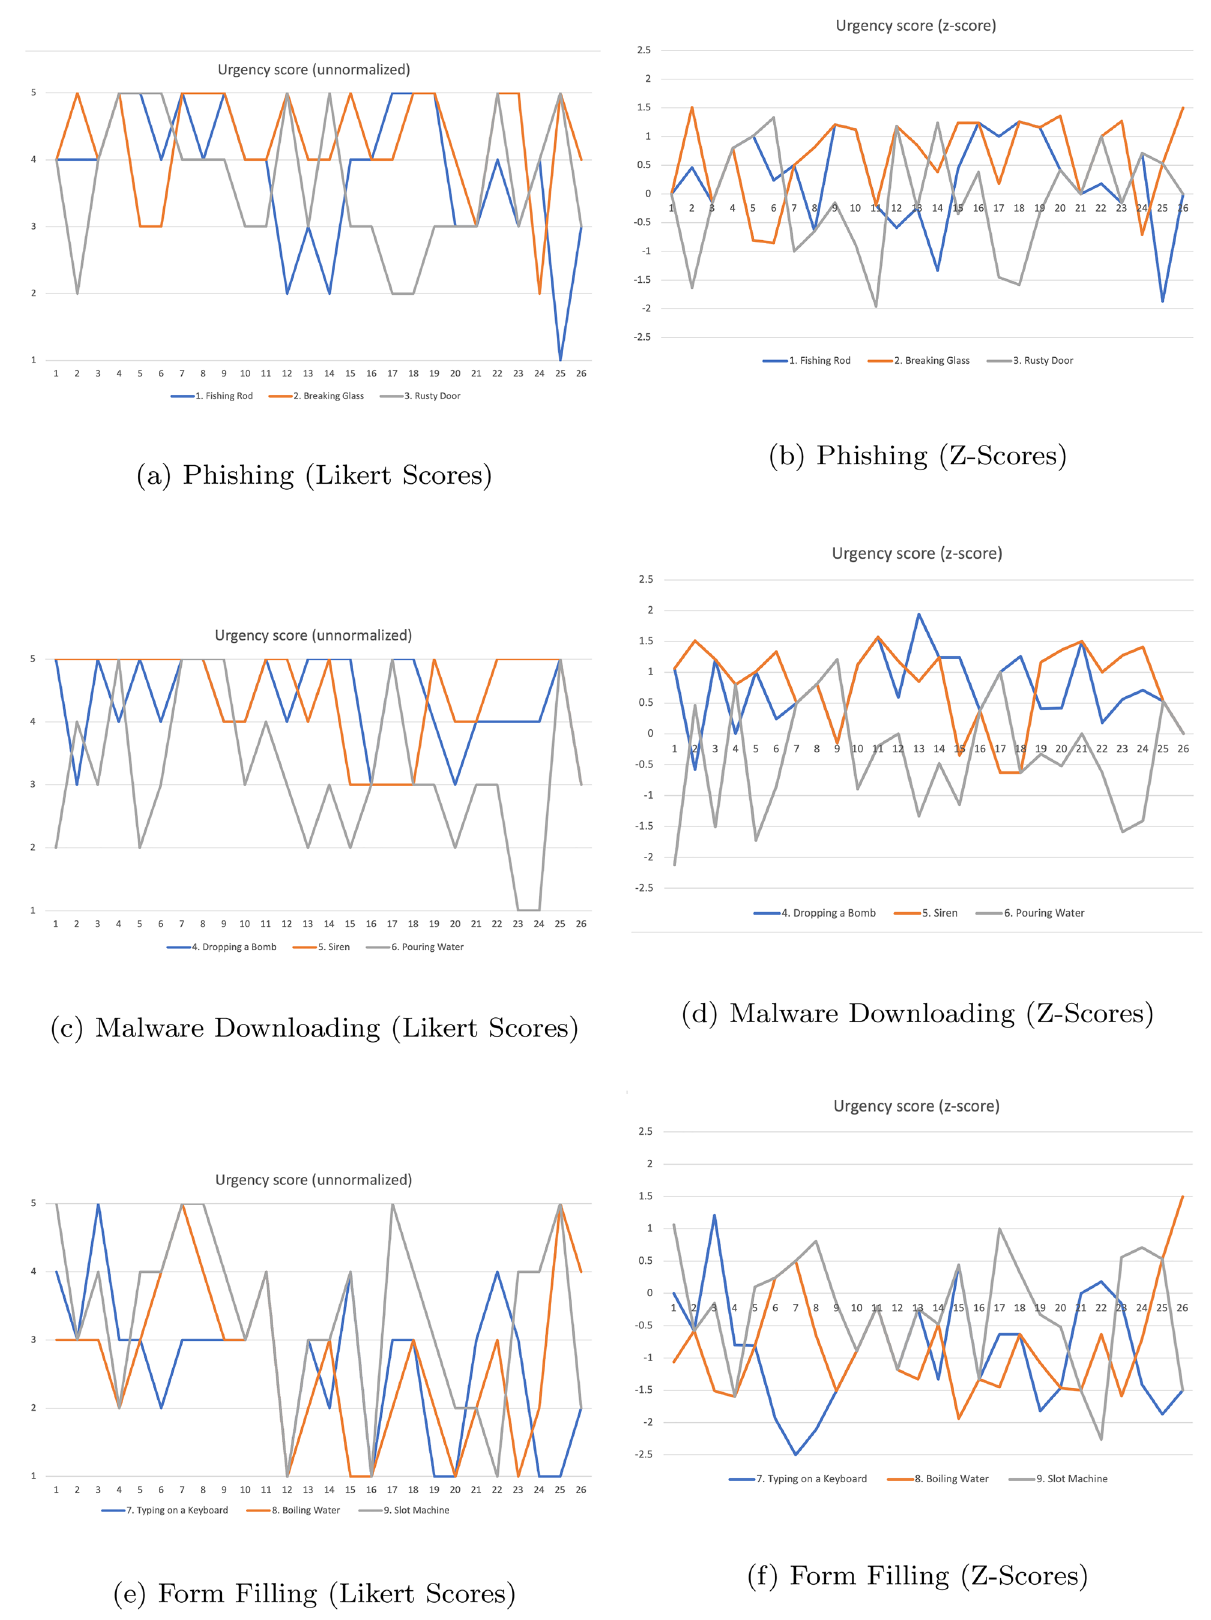
Fig. 6 The Unnormalized and Normalized scores for Urgency